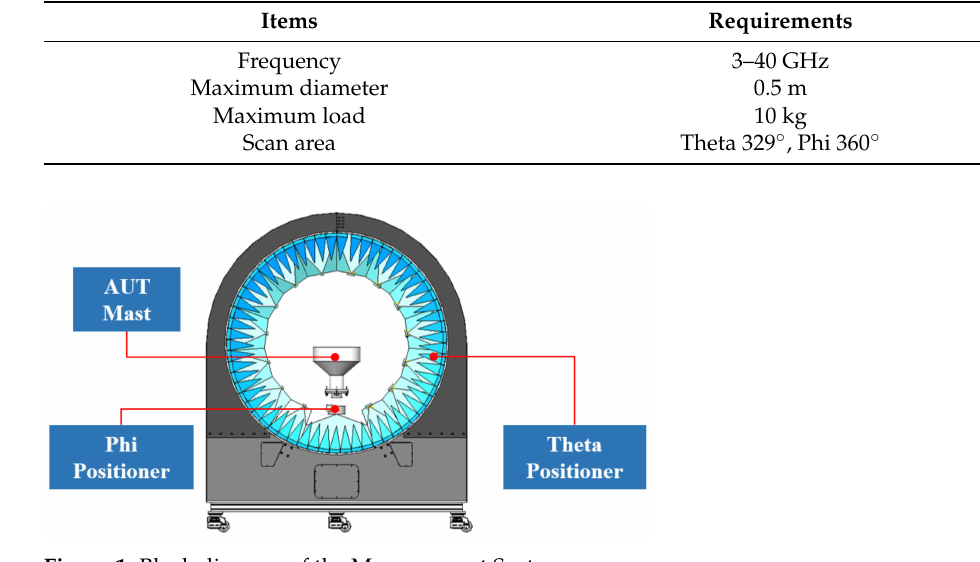
Figure 1. Block diagram of the Measurement